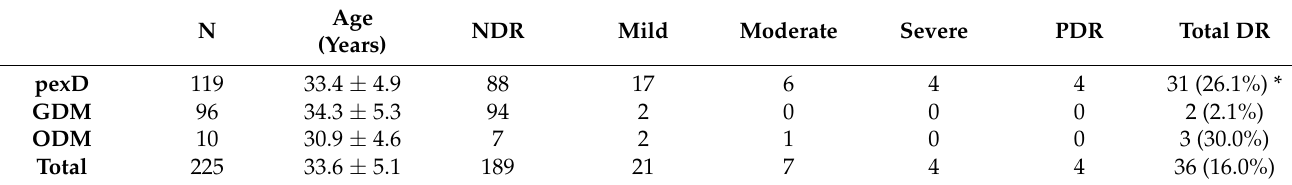
Table 3. The distribution of DR stage from the multicenter cohort.